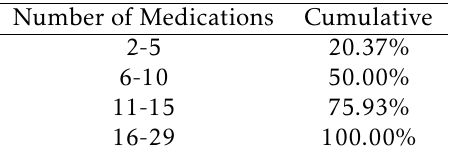
Table 2. Percentile definitions of number of medications. Ranges are boundary-inclusive.